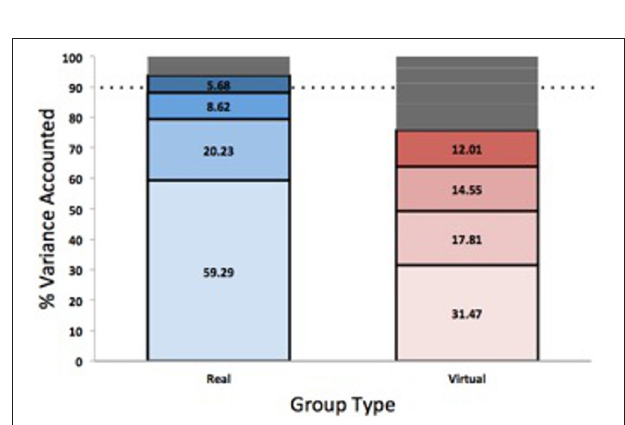
FIGURE 4 | The amount of variance accounted for by each component beginning with PC1.